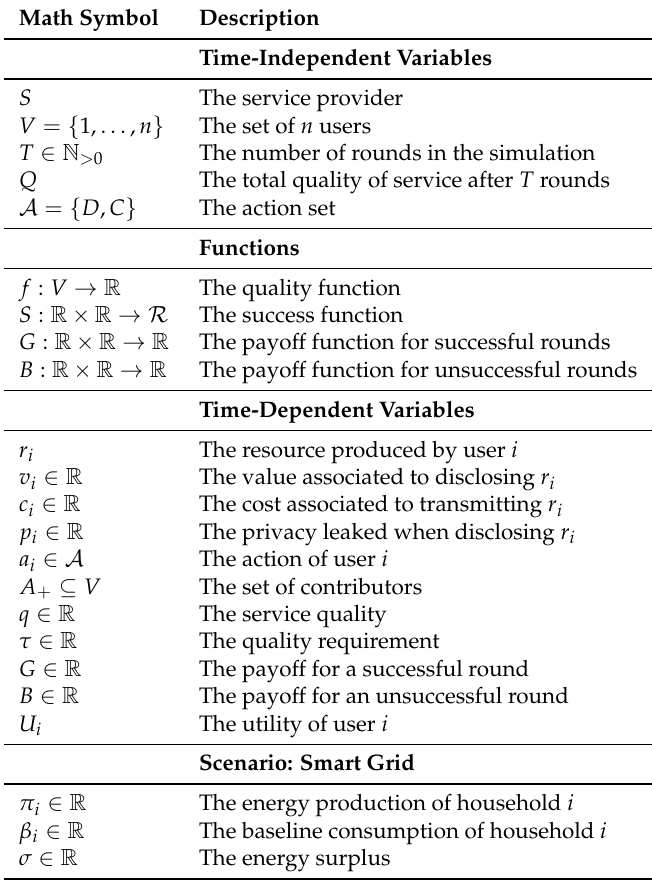
Table 1. Mathematical notation, in order of